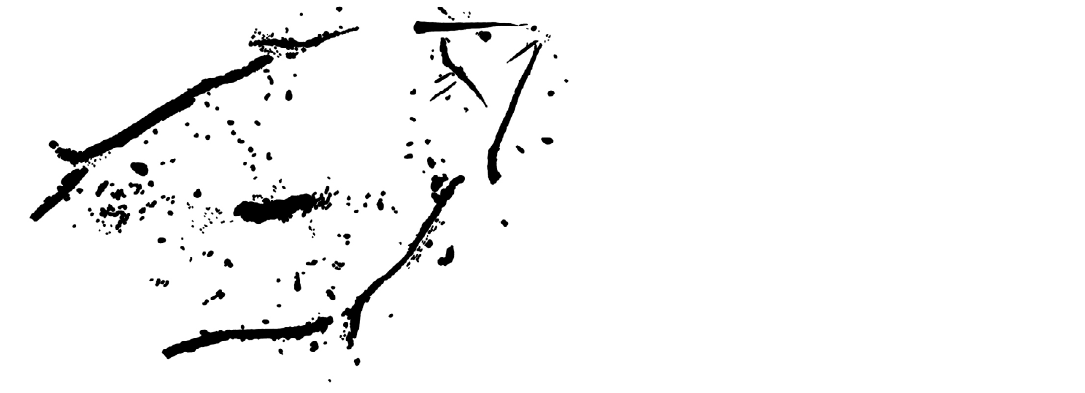
Figure 6. Fish motif in Penascosa Rock 5, Côa Valley, Portugal. This was the only known fish depiction attributed to the Gravettean-Solutrean period until recent discoveries occurred (Santos, 2015, p. 83). Tracing: Fernando Barbosa, assisted by Manuel Almeida and António Martinho